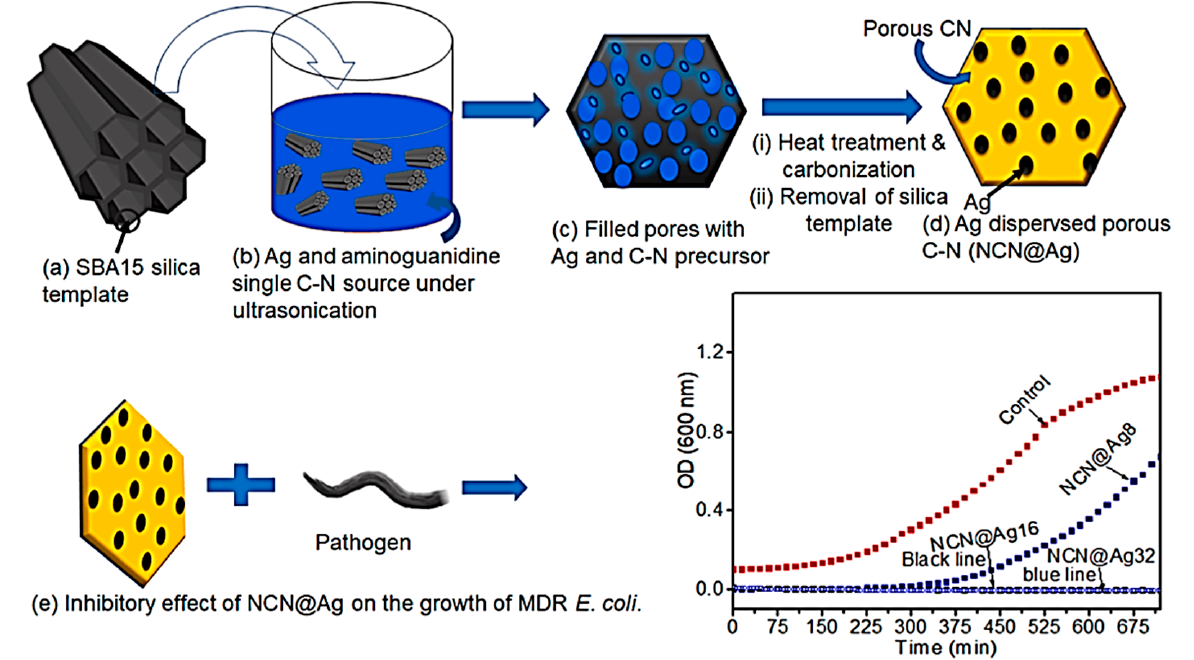
Figure 6. Ag NPs doped CN, ( a ) SBA15 silica substrate; ( b ) Ag and C-N with SBA15 silica; ( c ) Ag doped C-N; ( d ) Ag doped porous CN; and ( e ) Inhibitory action against MDR E. coli . [57].